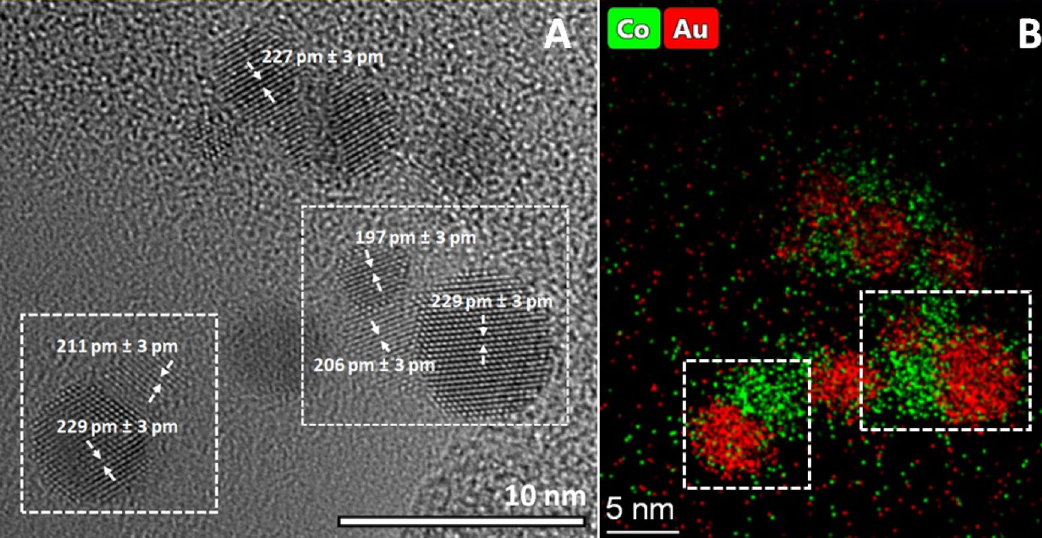
Figure 4. TEM image of Au/Co particles (generated at 1.0 Ω circuit resistance) after heat treatment at 900 °C ( A ), and elemental map of the same area as obtained by SEM–EDS analysis ( B ). Dashed squares indicate typical particles subjected to